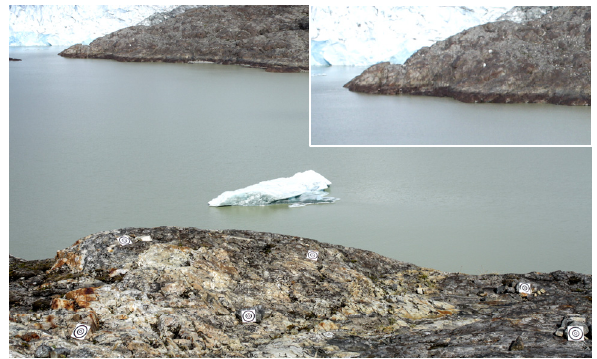
Figure 5. Camera image with fiducials in the foreground; shoreline enlargement (top